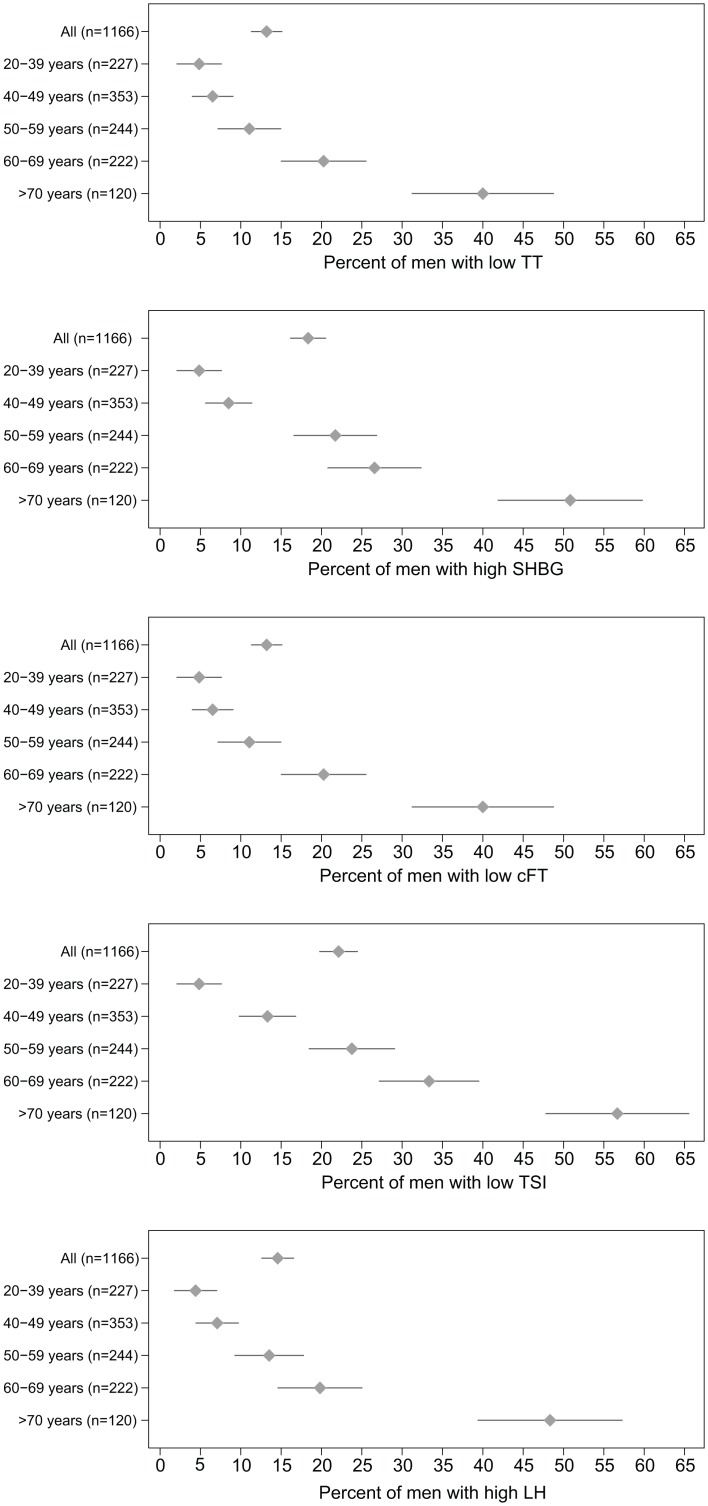
Percent abnormal hormone concentrations by age among older men.Mean (diamond) and 95% confidence interval (line) of the percent abnormal hormone concentrations among men, by decade of age, based on cutoff values shown in Table 2.